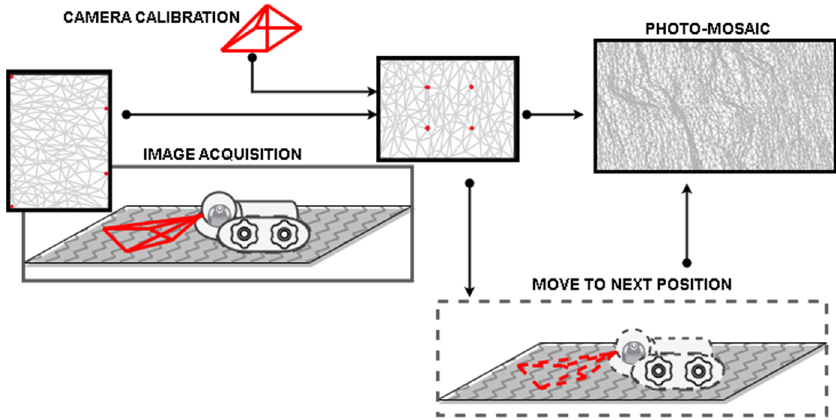
Figure 9. The flux diagram of the Python code for the automated production of photo-mosaics.